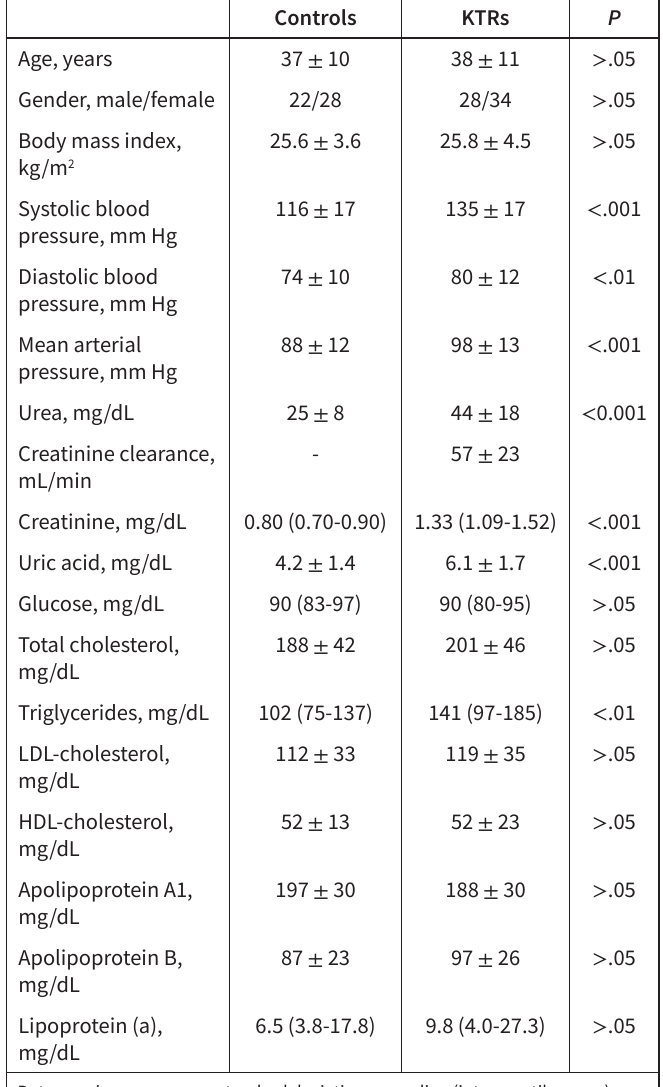
Table 1. Clinical and Biochemical Variables of the Study Groups